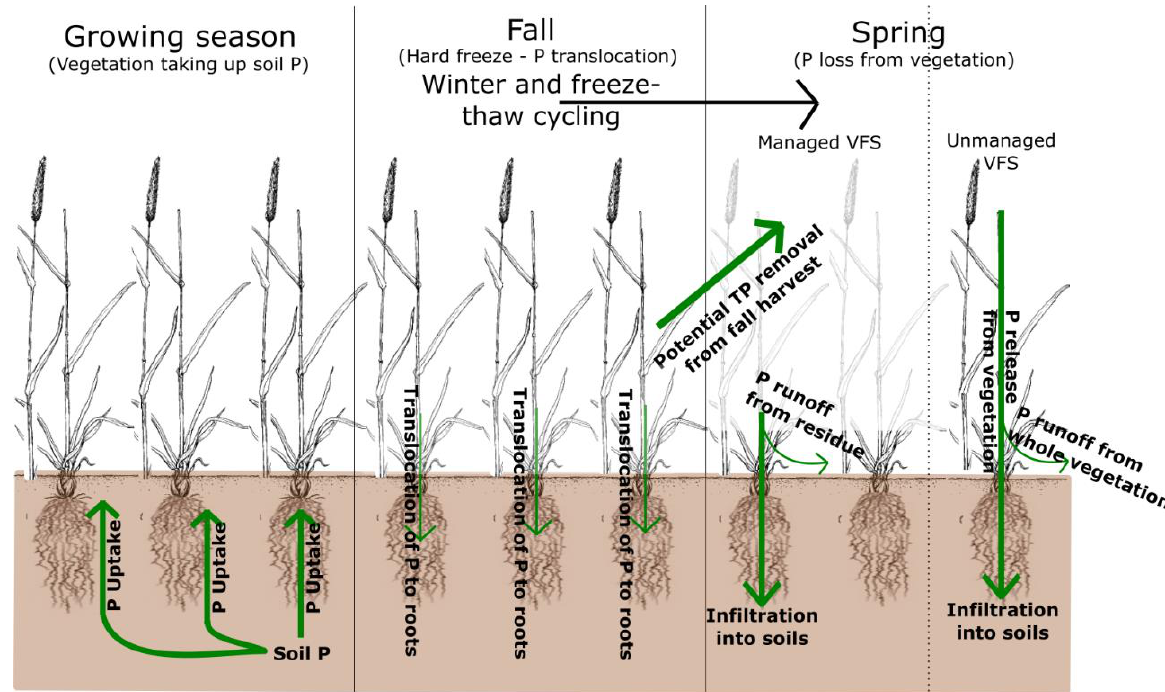
Figure 6. A diagram showing phosphorus (P) dynamics in a managed or unmanaged (farthest right panel) vegetated filter strip (VFS). Throughout the growing season, vegetation in the VFS is taking up soil P, but after the first hard freeze, usually in late fall, vegetation will begin to translocate P from the shoots to the roots. Harvesting vegetation in the fall is beneficial because it removes P from the VFS and reduces its P release capacity, though release from residue will occur. In completely unmanaged buffers (final panel), the capacity for P release is applied to the whole plant and may become a significant source of P to soils and eventually to runoff. Thicker arrows denote processes that were the focus of this study.